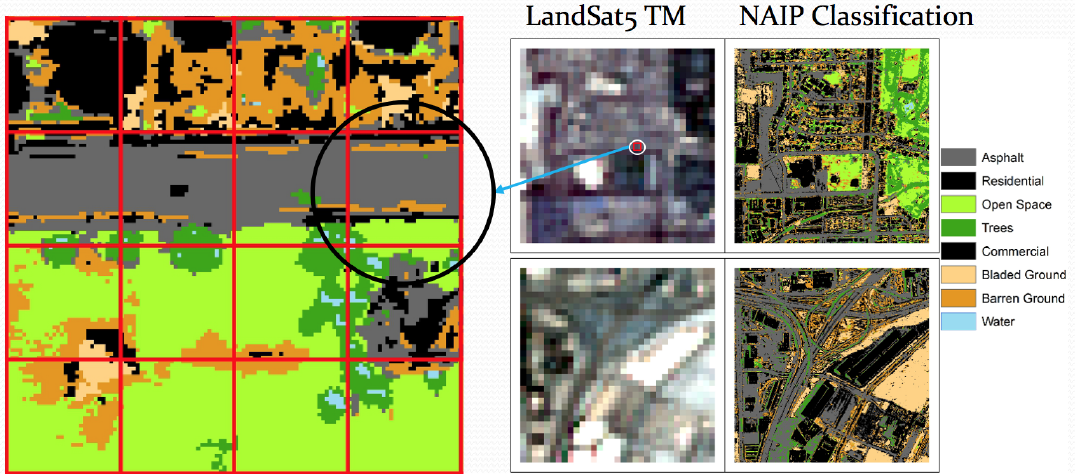
Figure 5. Comparison of classified NAIP image and TM image at two sites of Figure 3. A magnification of a 4 × 4 TM pixels with underlying NAIP pixels is shown on the